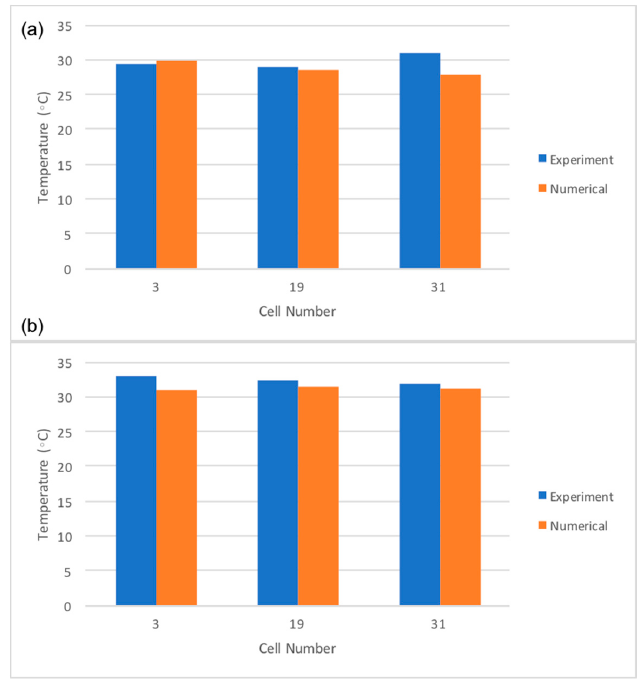
Figure 7. Model validation: ( a ) temperatures at location L1 and ( b ) temperatures at location L2 in Figure 5a.